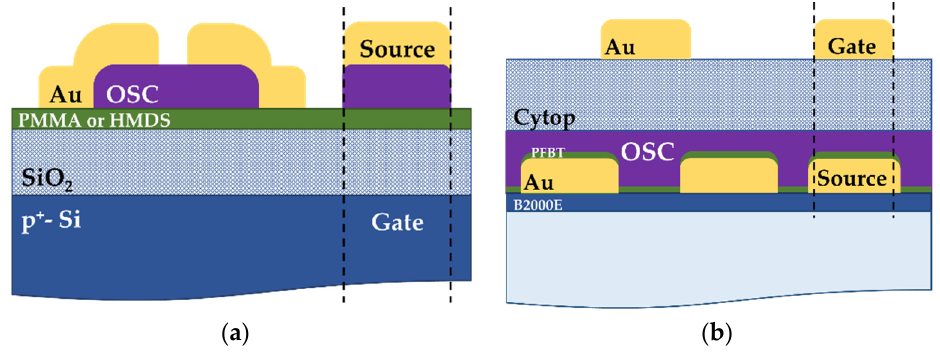
Figure 1. Cross-sections of the fabricated OTFTs and, bounded by the dashed lines, the equivalent MIS capacitors in ( a ) BG/TC configuration and ( b ) TG/BC